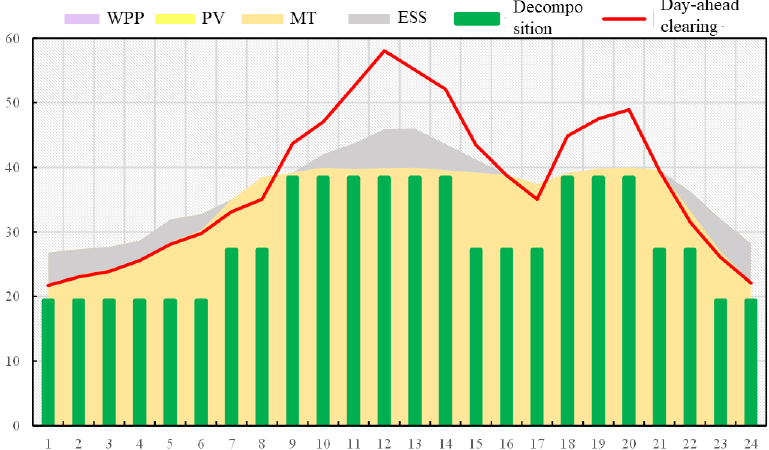
Figure 10. VPP operation status without renewable energy output (MWh).